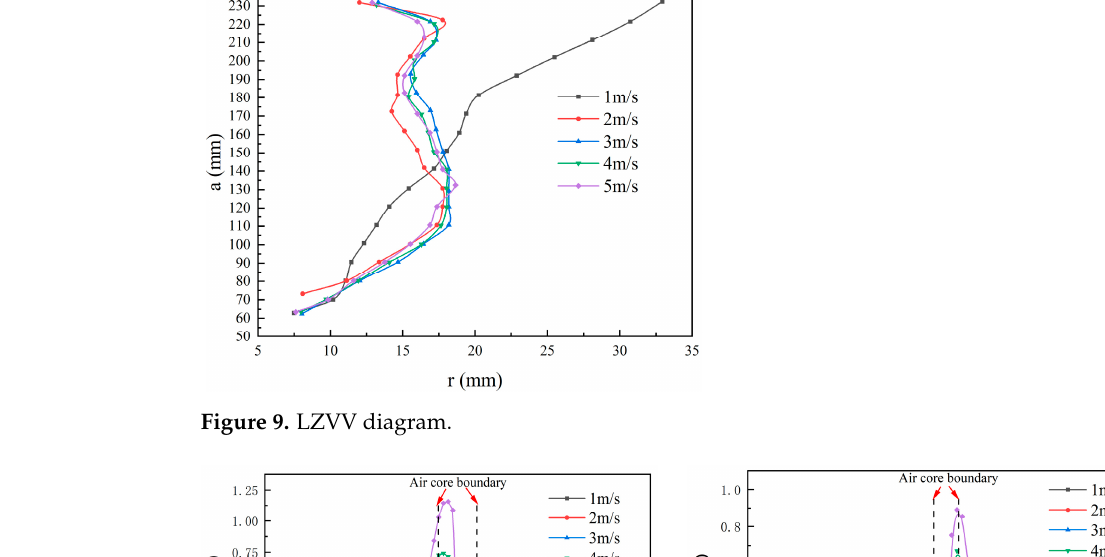
Figure 9. LZVV diagram.